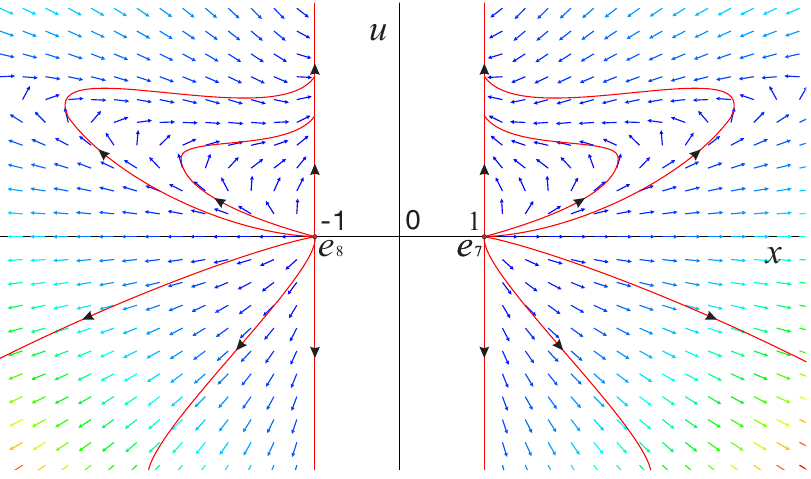
Figure 7. The phase portrait on the invariant surface f + ( x , z , u ) = 0 restricted to the region u ≤ z . Note that system (16) can be transformed into a polynomial differential system by let- √ x 2 − 1 when | x | (cid:54) = 1. In order to study the dynamic behavior of the equilibrium ting y = points of system (16) at infinity, we first study the infinite equilibrium points of system